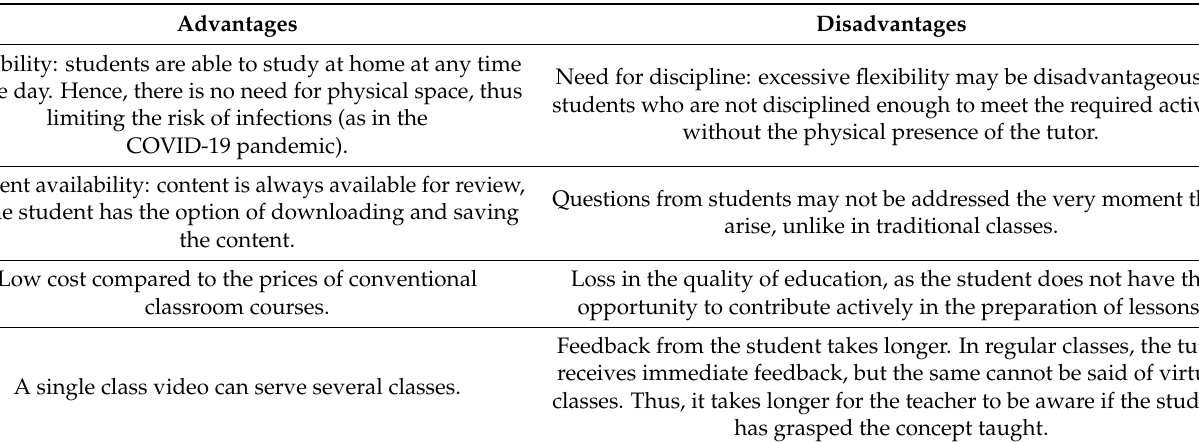
Table 1. Advantages and Disadvantages of distance